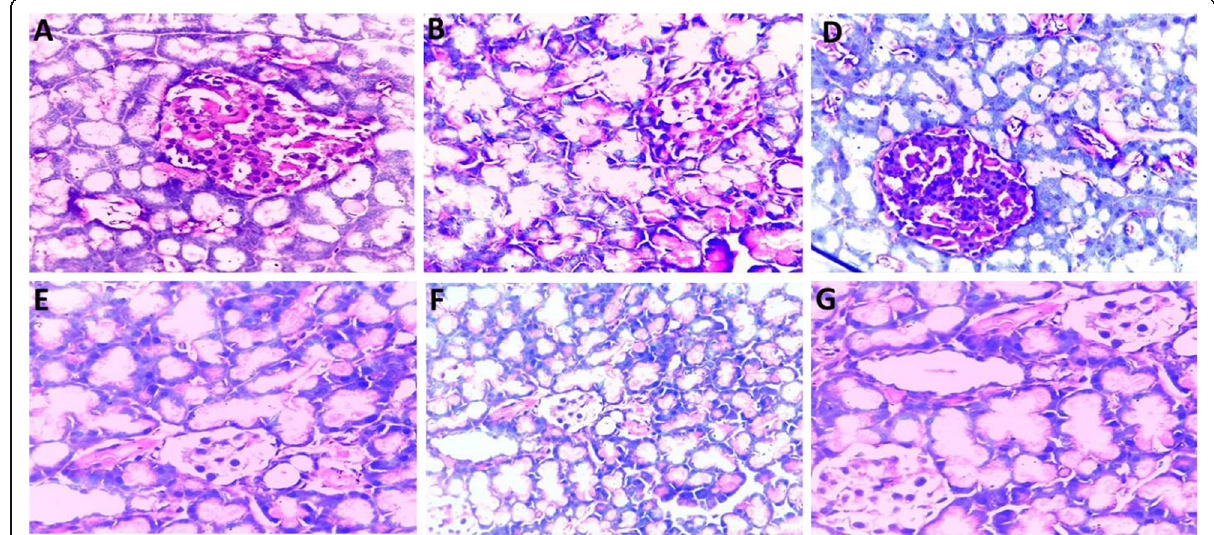
Fig. 5 Microscopic observation of the pancreas in the experimental tissue section. a Normal control-presence of normal pancreatic islet cells. b Diabetic control-degranulated and dilated islet cell. c Diabetic+glibenclamide (0.5 mg/kg)-granulated, nonappearence of dilation, and important hyperplasticity of islets. d Diabetic+EEPM (50 mg/kg) pancreas showing islets with endocrine cells showing more cytoplasm and normal endocrine acini. e Diabetic+EEPM (100 mg/kg)-granulated pancreatic islets, showing prominent hyper plasticity islets. f Diabetic+EEPM (200)- granulated pancreatic islets, showing major hyperplasticity